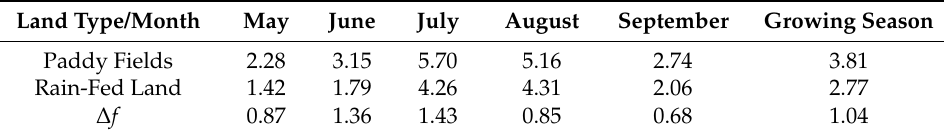
Table 1. f values and ∆ f for unchanged pure pixels of paddy fields and rain-fed land during May to September, as well as the growing season in the Sanjiang